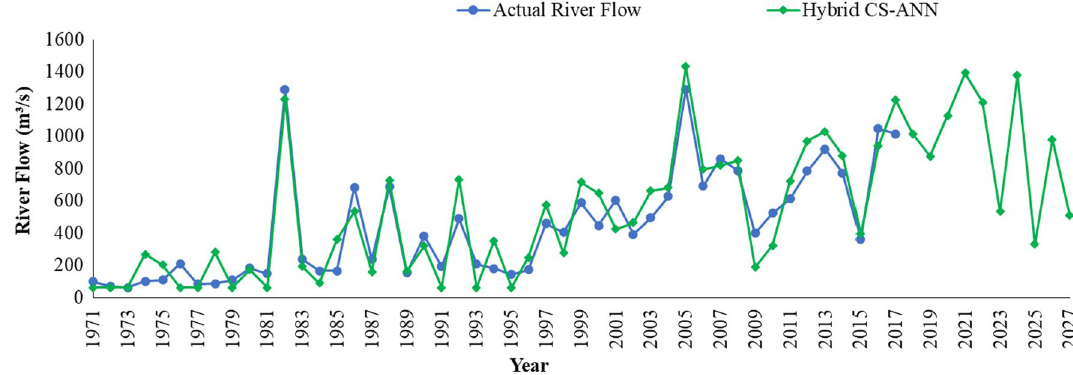
Fig. 5 Predicted River Flow into hydropower plant from year 1971 to